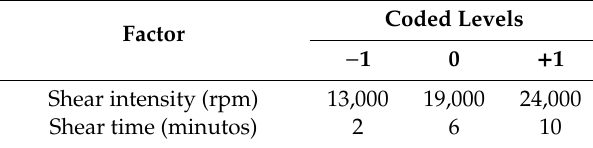
Table 1. Preparation of resveratrol-loaded nanostructured lipid carriers (NLC). Factorial design, providing the lower ( − 1), upper ( + 1), and (0) central point level values for each variable.